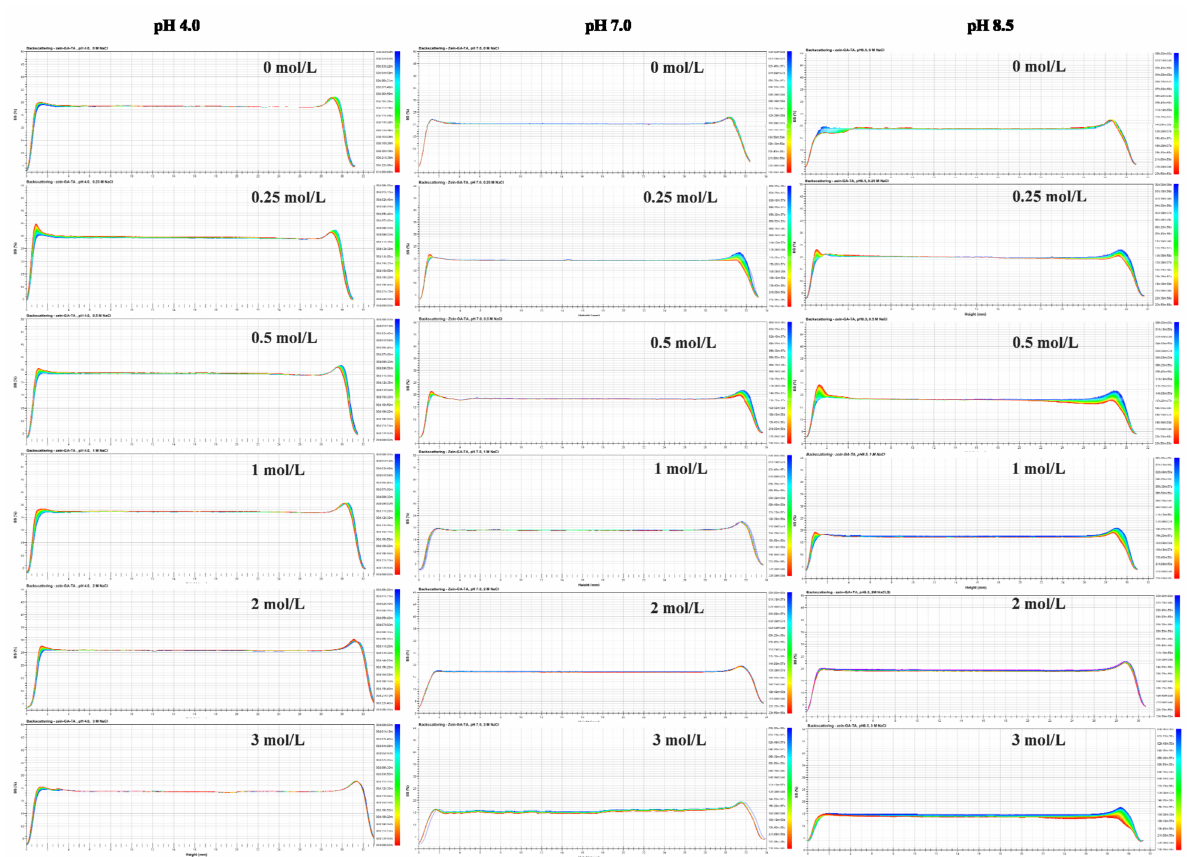
Figure 3. Backscattering changes of zein–GA–TA gel particle dispersions at different pH values (4.0, 7.0, or 8.5) and different concentrations (0, 0.25, 0.5 1, 2, 3 mol/L) of sodium chloride. And x-axis means height (mm), y-axis means BS